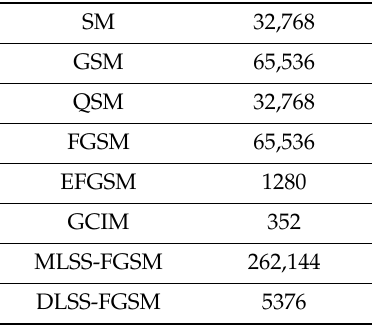
Table 3. Performance comparison of